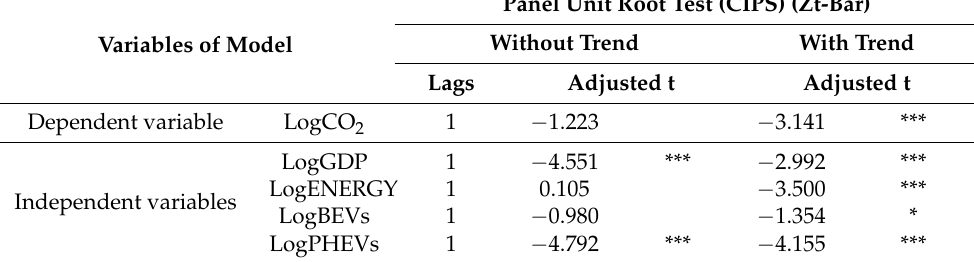
Table 6. Panel Unit Root